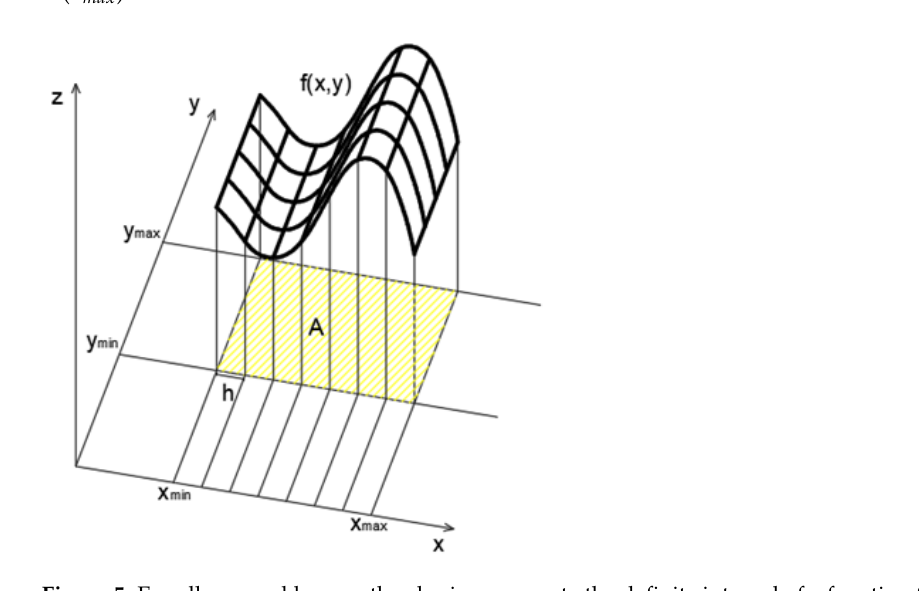
Figure 5. Equally spaced lags on the abscissa compute the definite integral of a function f(x, y). The approximation of definite integral is obtained using three numerical integration formulas: extended trapezoidal rule (Equation (10)), extended Simpson’s rule (Equation (11)) and extended Simpson’s 3/8 rule (Equation (12)):